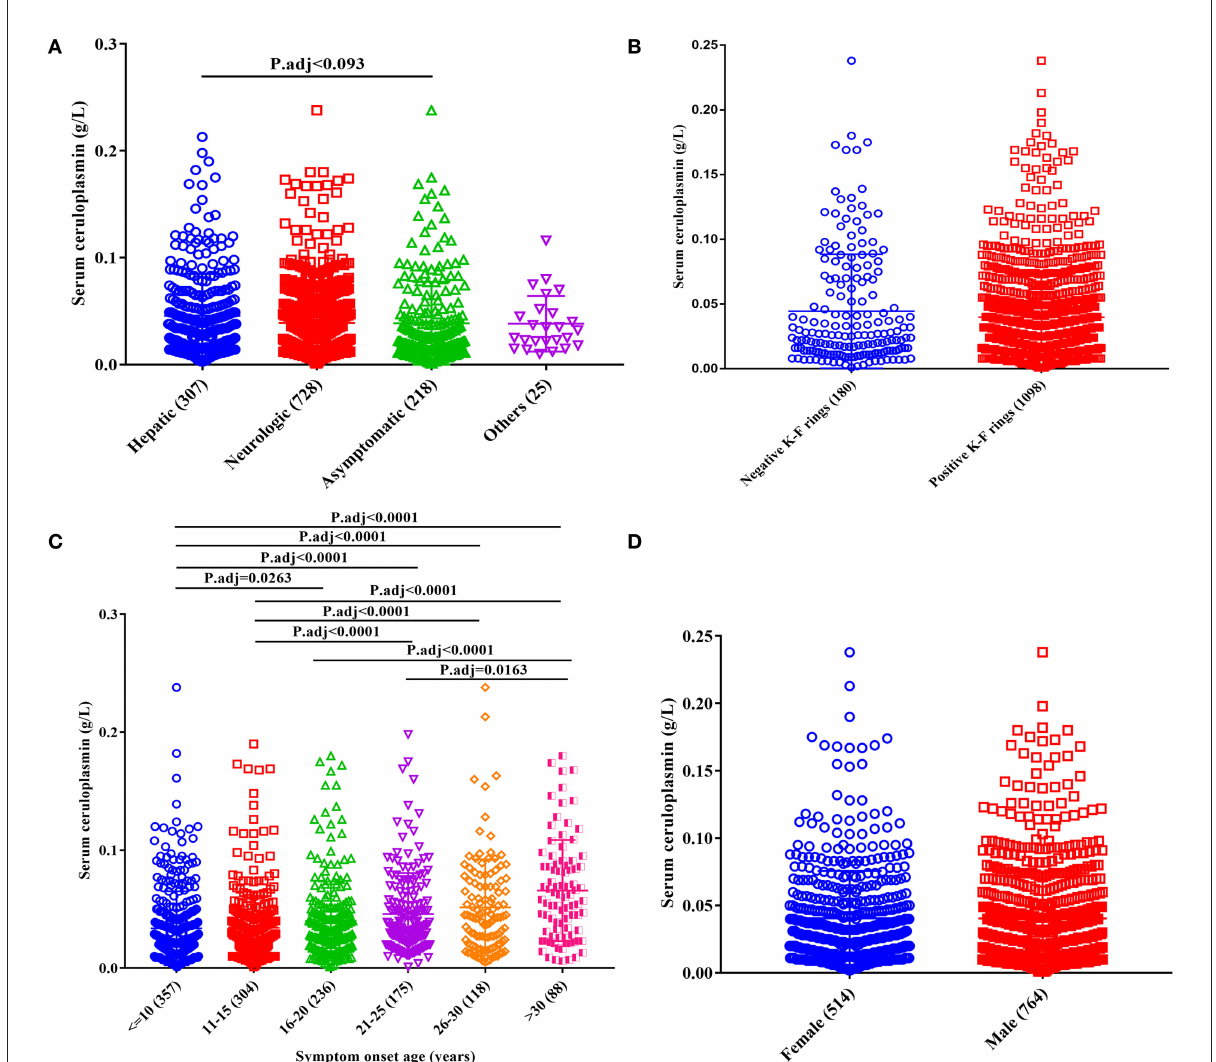
FIGURE2 Effect of clinical phenotypes on serum ceruloplasmin levels of patients with WD. (A) Clinical subtypes; (B) presence of K–F rings; (C) age at onset; (D)